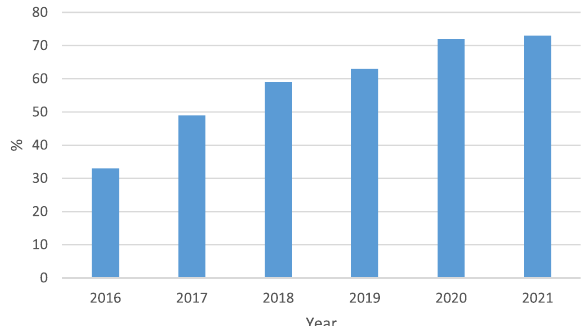
Fig. 2 Familiarity with the concept ‘ Smoke-free Generation ’ . Proportion of Dutch respondents (annual representative sample ≈ 1000 adults) acknowledging familiarity with the ‘ Smoke-free Generation ’ concept. Data collected by Kantar Public on behalf